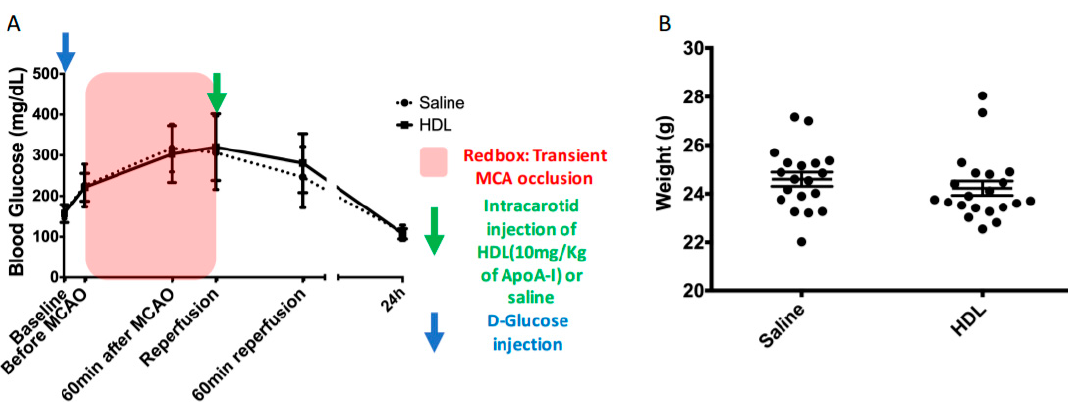
Figure 1. Timeline of acute hyperglycemia, MCAO, and intracarotid injection procedures. Body weight of mice before surgery. ( A ): IP injection of D-glucose at the initial time (blue arrow). Plasma glucose levels of saline- and HDL-injected mice during the procedures. The red box represents the ischemic period. The green arrow indicates the time of intracarotid injection of HDLs or saline. ( B ): Body weights of mice were not different between groups.